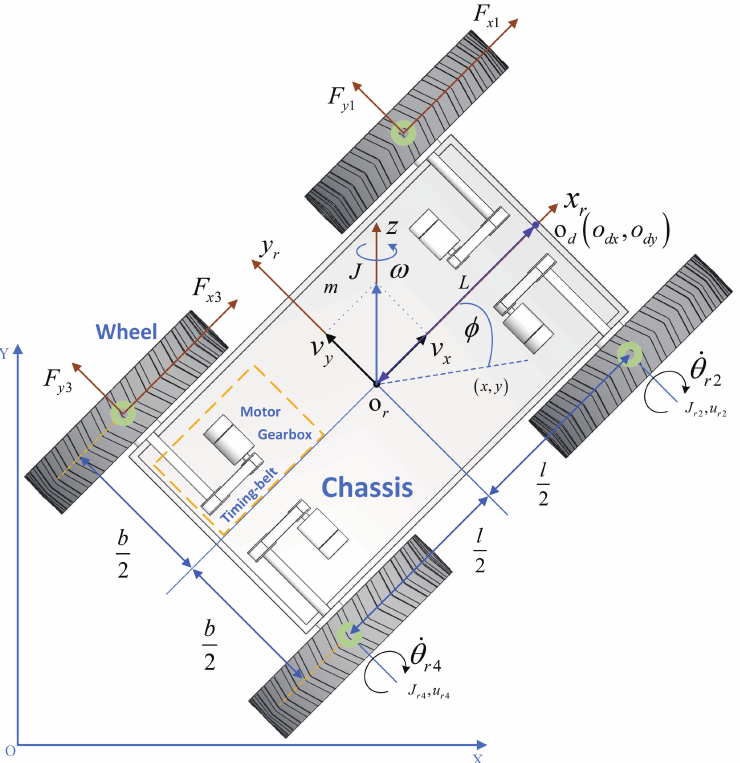
Figure 1. Top view of the four-wheel, independent skid-steer mobile robot with timing-belt servo